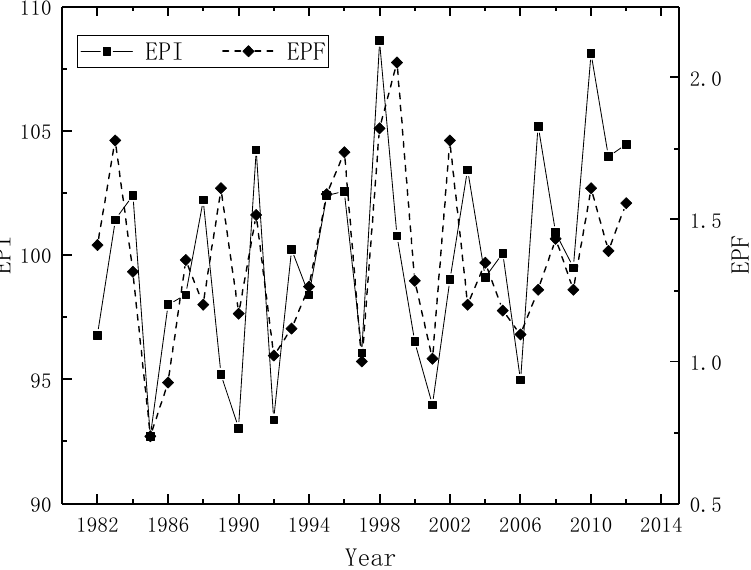
Figure 3. Temporal variations in the extreme precipitation intensity (EPI) and extreme precipitation frequency (EPF) in the MLR-YR from 1982 to 2012.